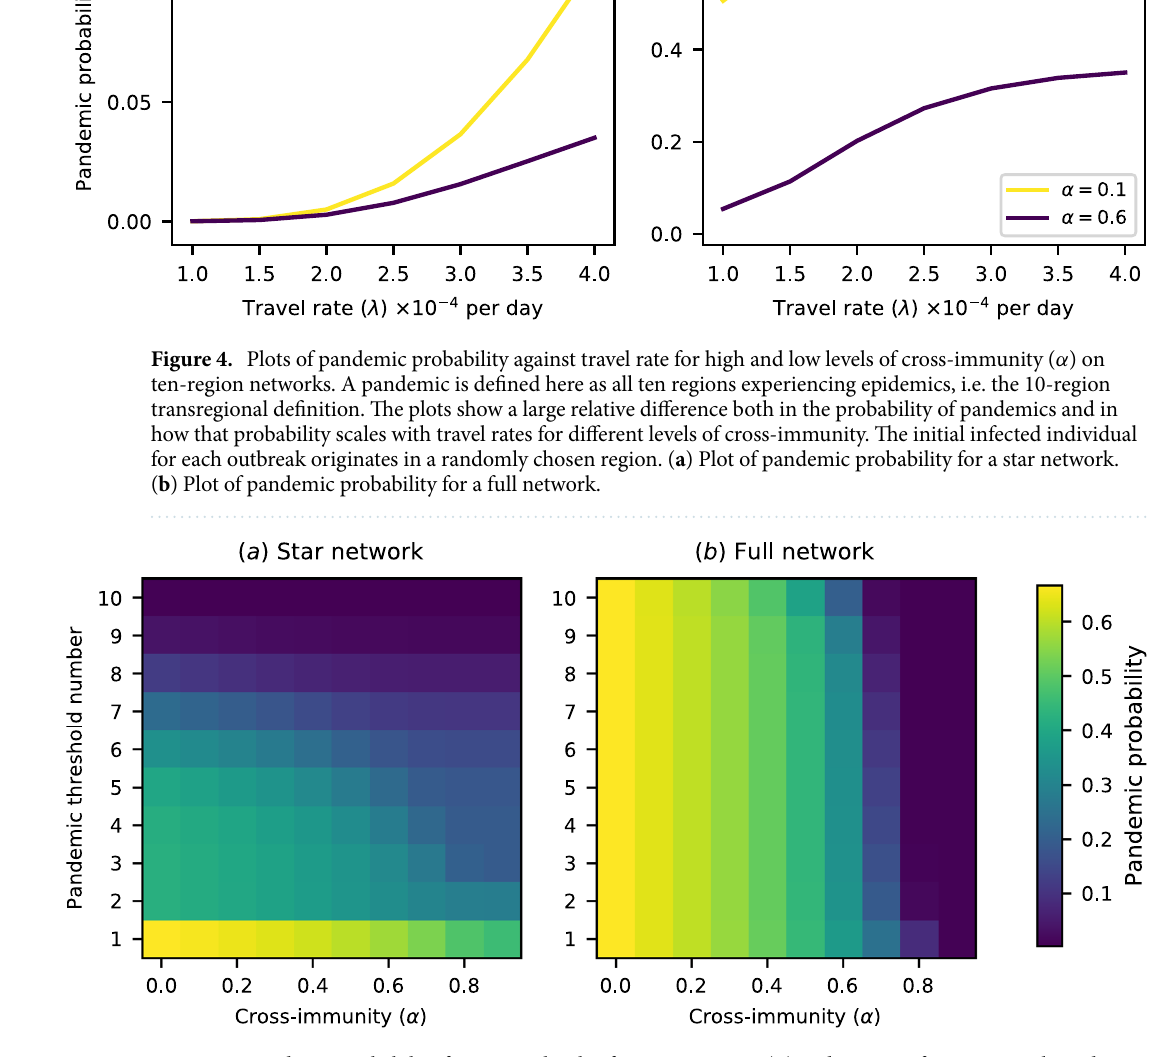
Figure 5. Pandemic probability for various levels of cross-immunity ( α ) and a range of transregional pandemic definitions, on a ten-region network. ( a ) Pandemic probability for a star network. ( b ) Pandemic probability for a fully connected network. Here the sensitivity of the pandemic probability to the pandemic definition used increases with cross-immunity, until the probability of any epidemic becomes very